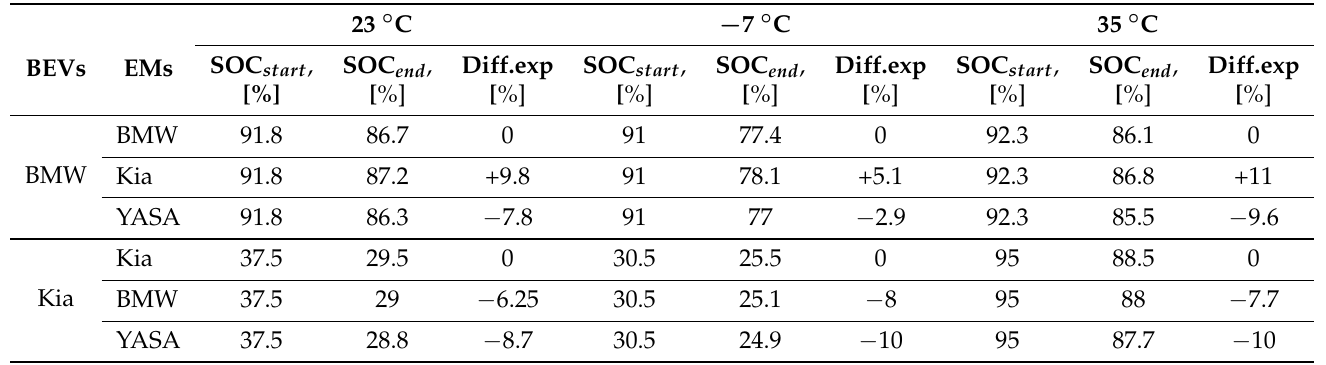
Table 5. SOC results with original EMs at different ambient